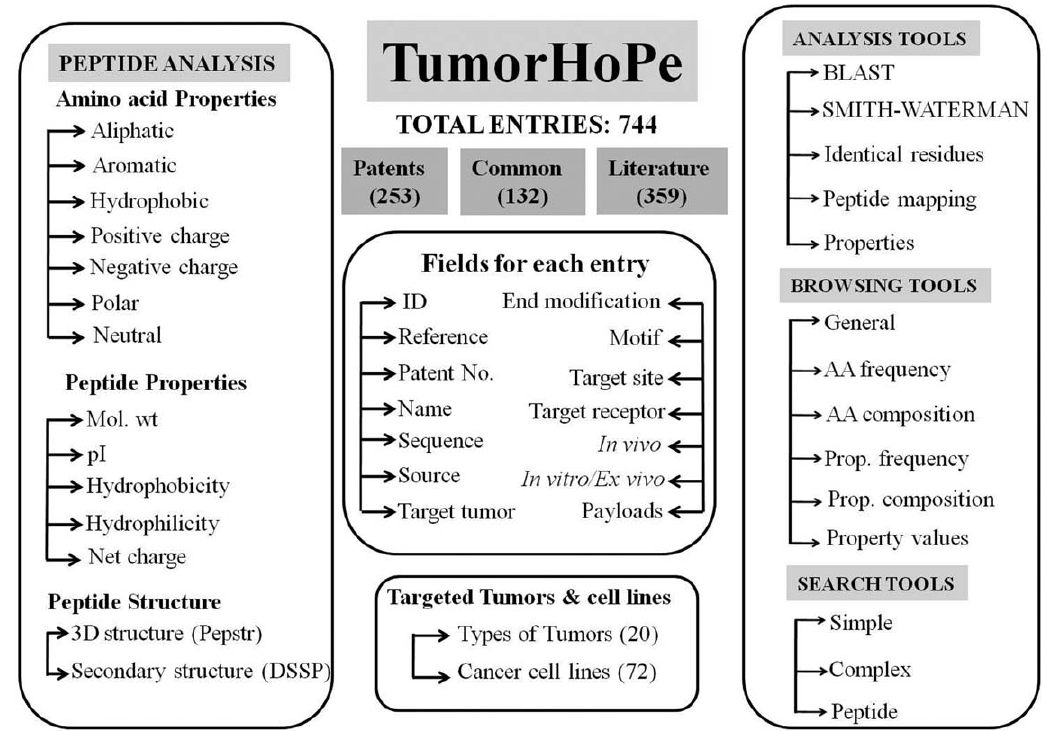
Figure 1. Overall architecture of TumorHoPe database.